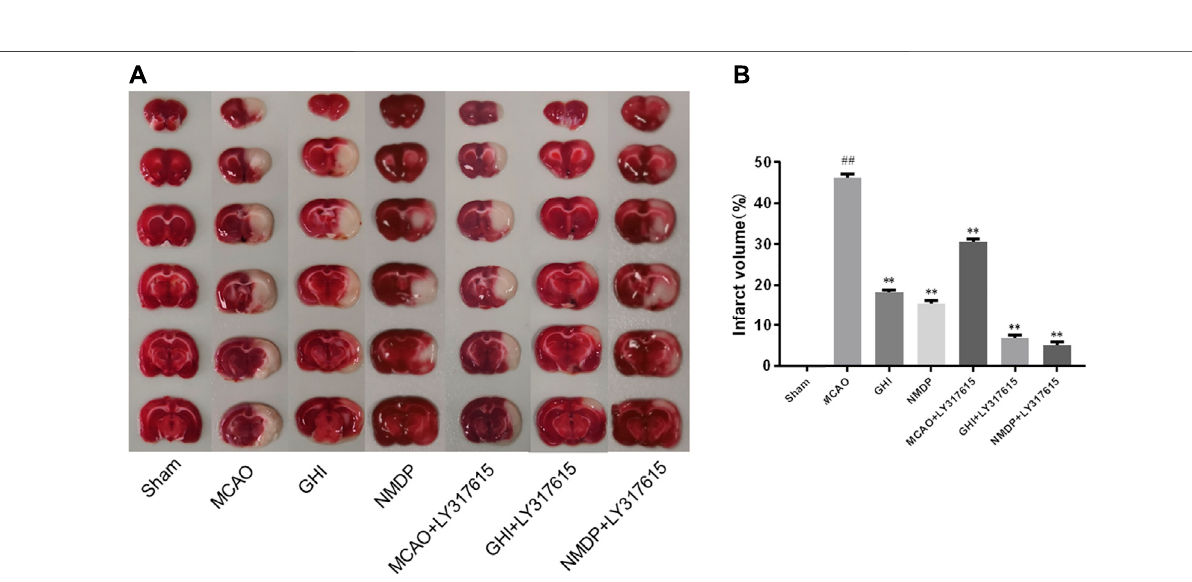
Frontiers in Pharmacology |